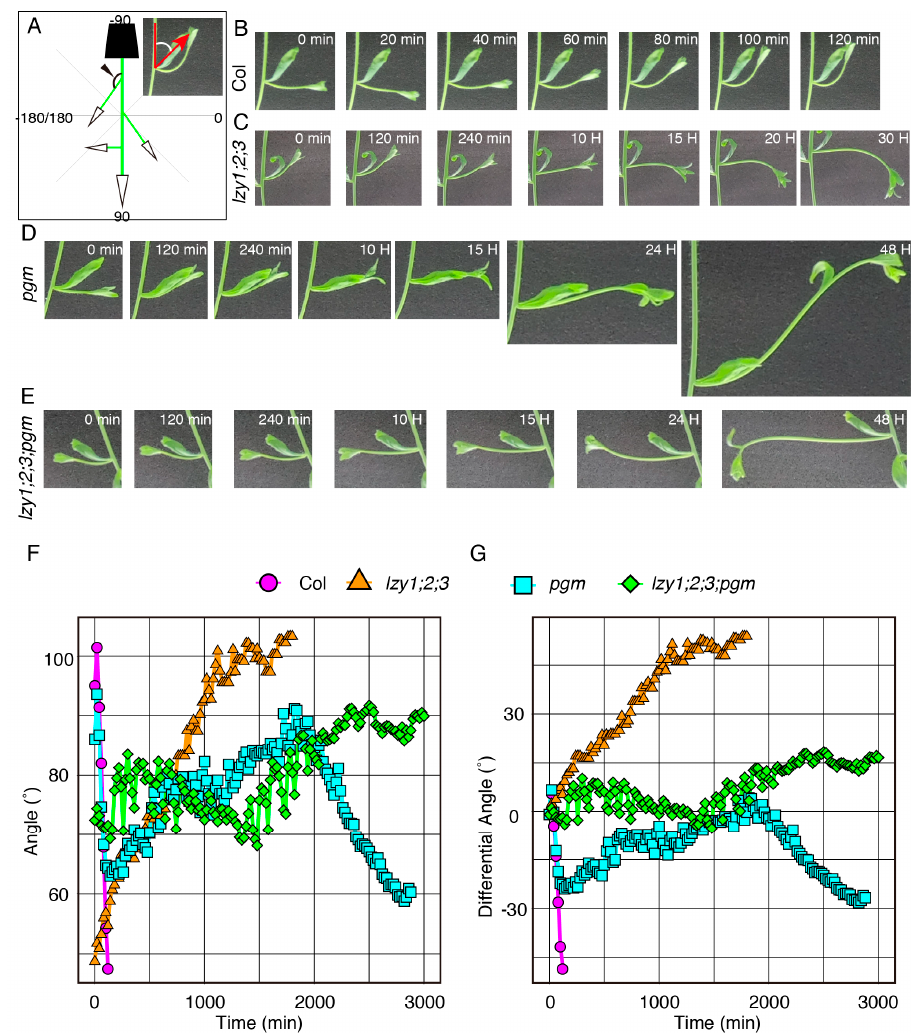
Figure 2. The gravitropic responses of lateral branches. ( A ) Graphical image of the quantification of growth angles of lateral branches. Time-lapse images of lateral branches from wild-type Col ( B ), lzy1;2;3 ( C ), pgm ( D ), lzy1;2;3;pgm ( E ) plants after inversion. Immediately after inverting plants, images were obtained at 5 min intervals. Quantification of growth posture change of lateral branches during the gravitropic responses ( F ) and differences of growth angle from initial angles ( G ).